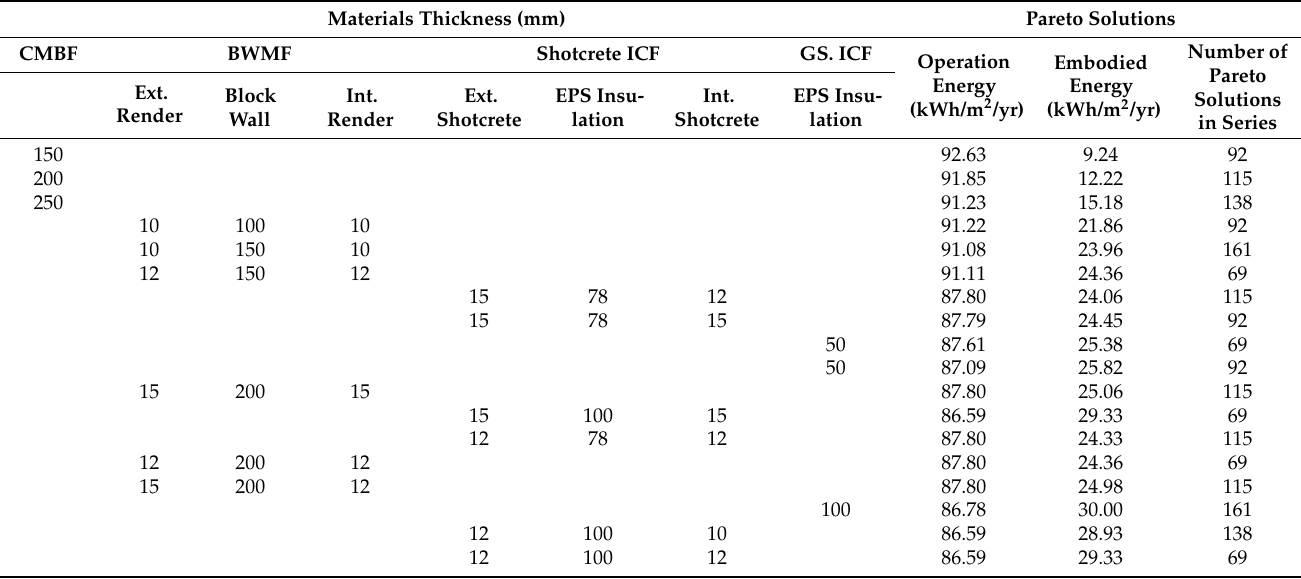
Table 5. Configuration of Pareto optimal solutions of stage